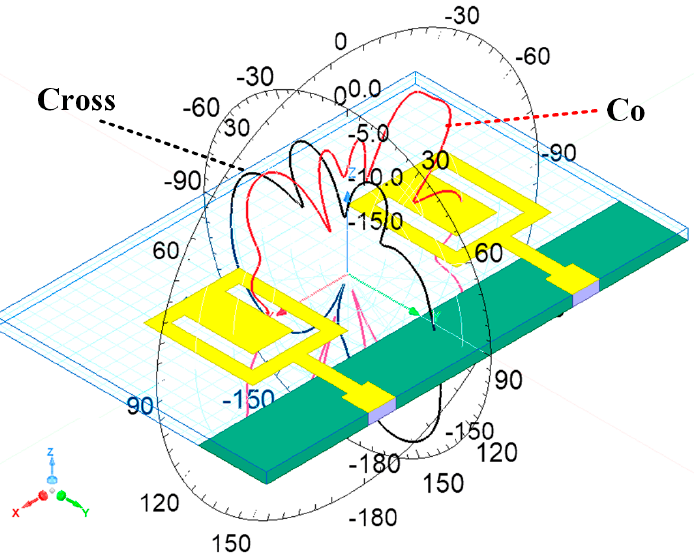
Figure 8. Graphical representation of the Co and cross-polarization field for the Hilbert-shaped antenna with its radiation pattern.